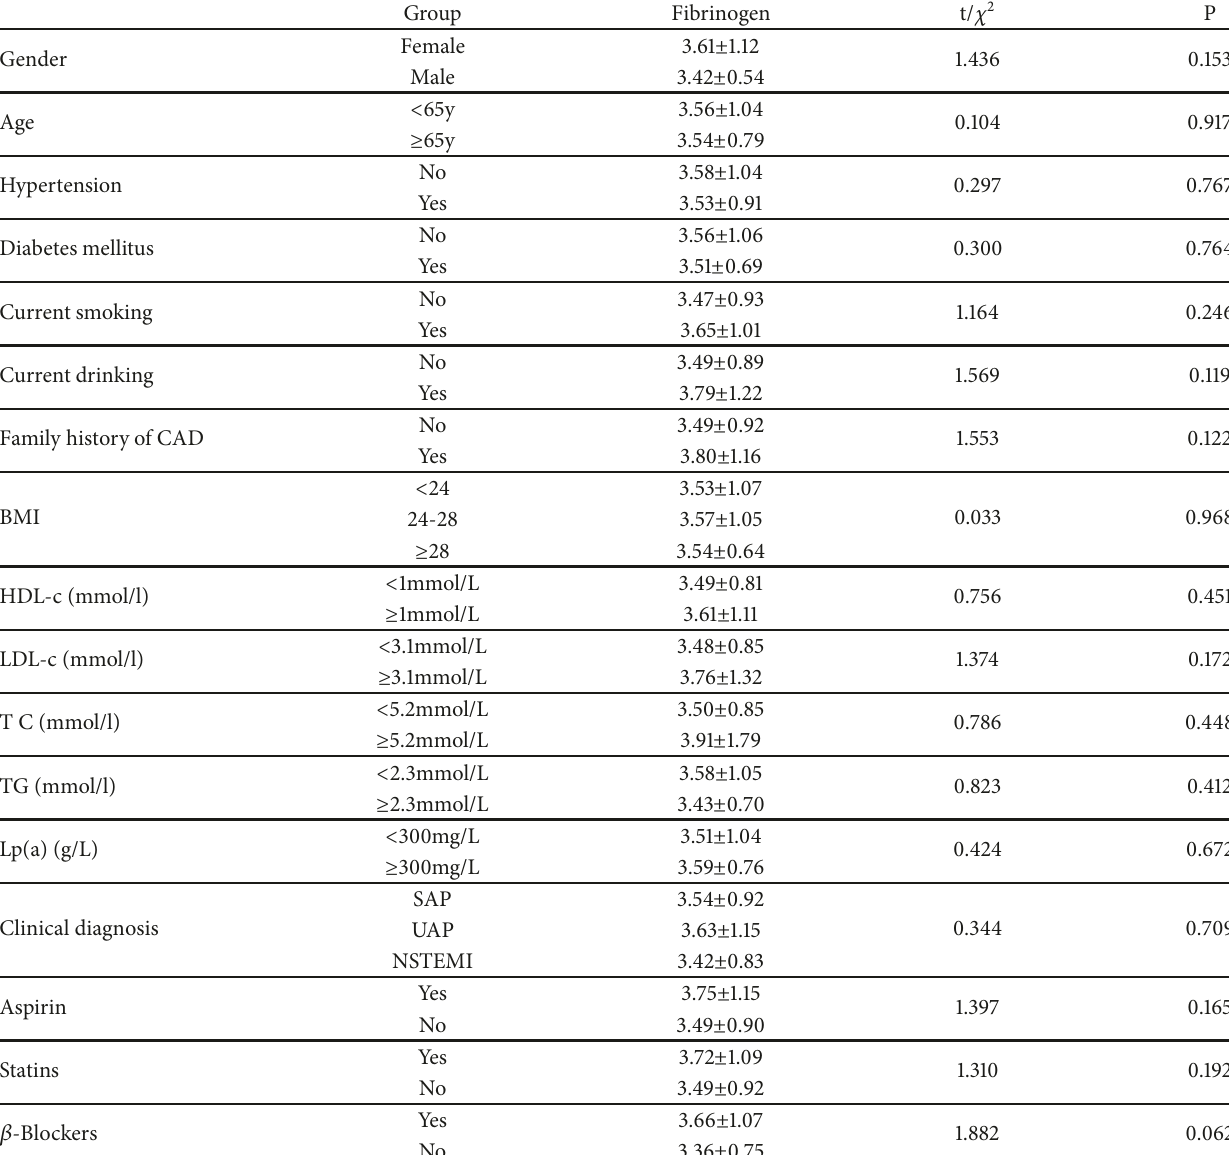
Table 4: Fibrinogen levels in patients with different